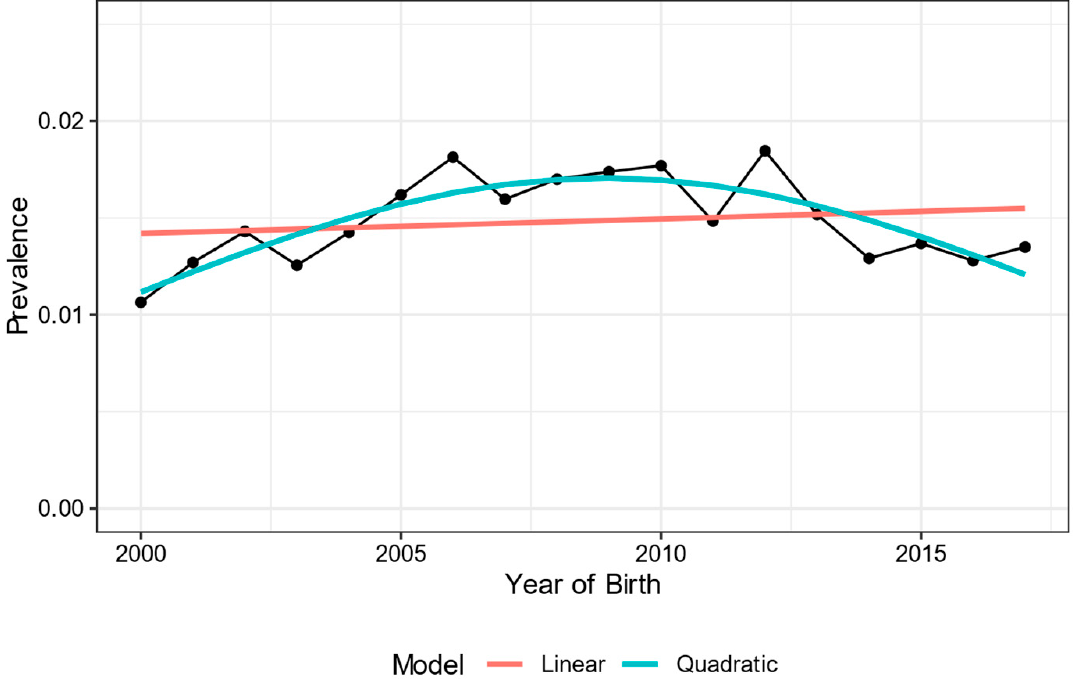
Figure 1. Prevalence of congenital anomaly per year among newborns in the city of Porto Alegre, Rio Grande do Sul, from 2000 to 2017 and model adjust (Bayesian criterion). Numerator: total number of newborns identified with CA. Denominator: total live births in the same year.